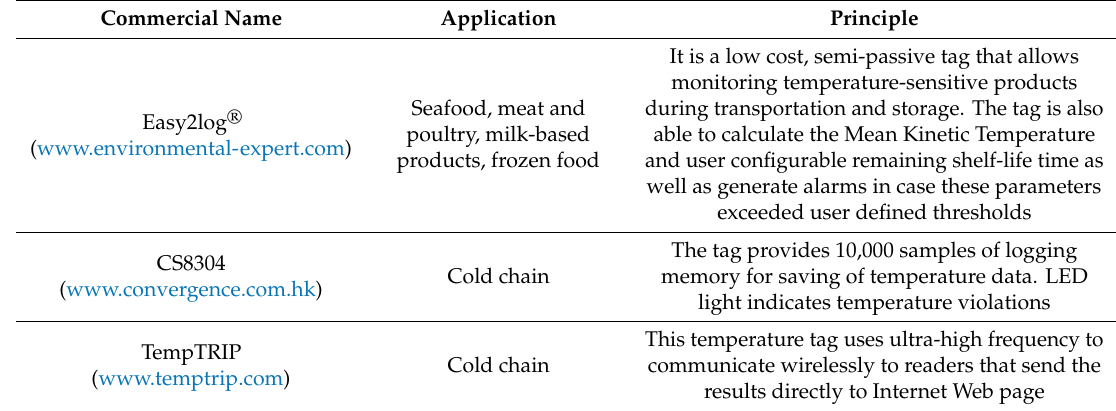
Table 8. Commercially available radio frequency identification systems (RFID)